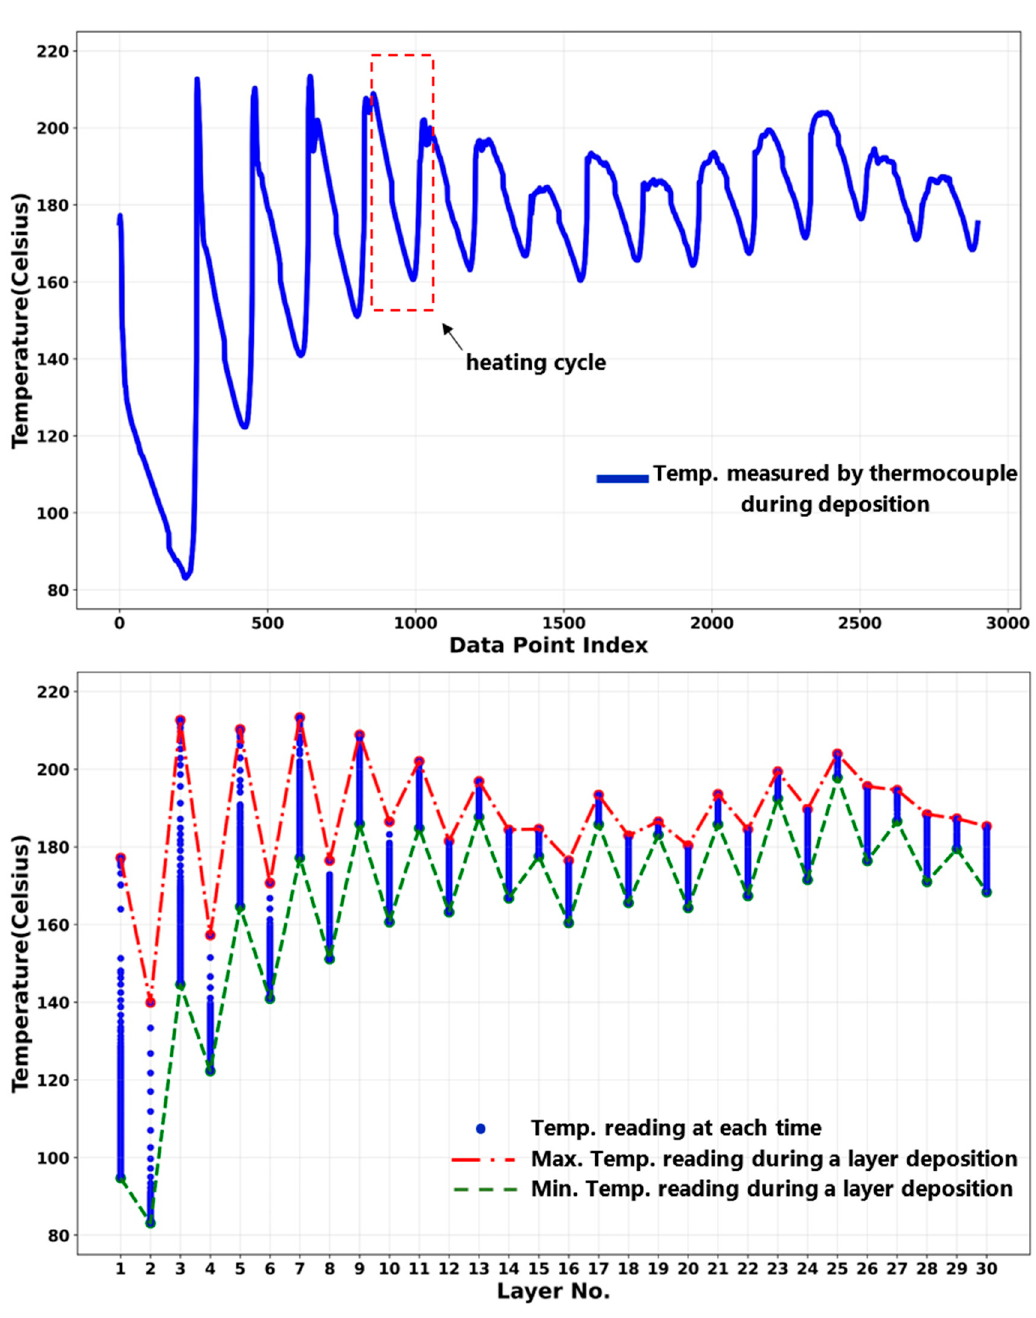
Figure 9. Temperature variation in the substrate during the deposition: ( top ) temperature history as a function of time; ( bottom ) temperature variation as a function of deposited layers.